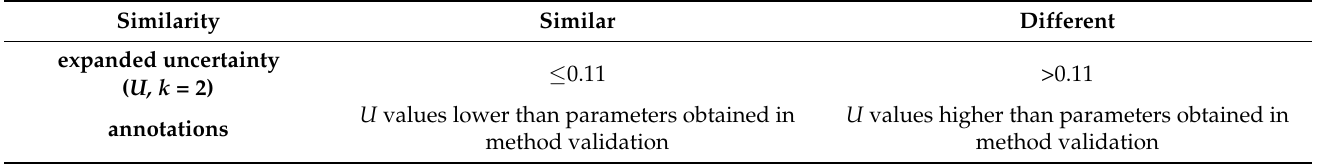
Table 3. Limits of CV and range values defining the similarity of samples in the comparative examination. Similarity Similar Different expanded uncertainty